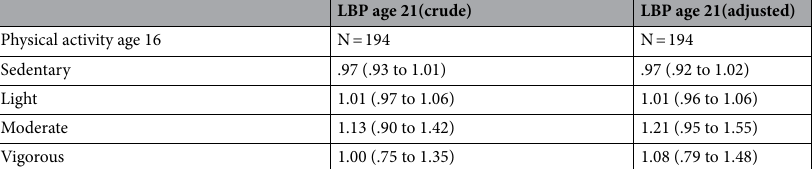
Table 2. Adjusted and unadjusted odds ratios for physical activity at age 16 and 21 years and low back pain at age 21 years a . a All values are odds ratios (95% confidence interval) per 10 min of physical activity. All estimates are adjusted for accelerometer wear time. Adjusted models additionally control for sex and body mass index at age 21.